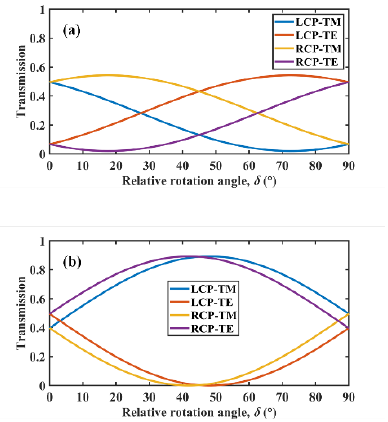
Figure 6. TE wave and TM wave components in the transmitted wave as a function of the rotation angle for LCP and RCP waves: ( a ) single layer slab ( f = 0) and ( b ) single-layer rectangular strips structure ( f = 0.6).